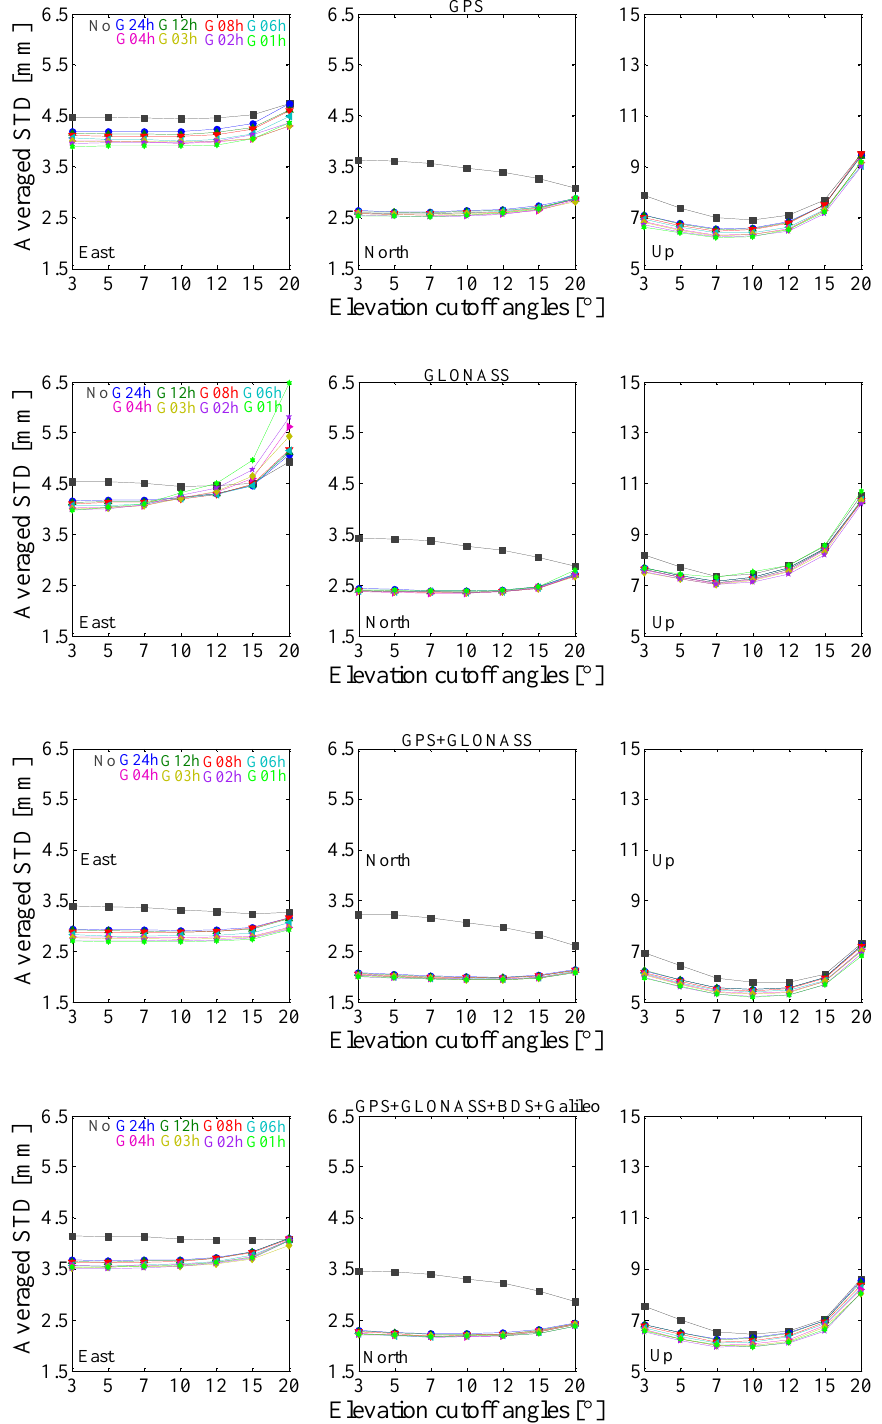
Figure 6. The averaged position repeatability as a function of satellite elevation cutoff angles of the 61 stations for GPS-, GLONASS-only, GPS + GLONASS and GPS + GLONASS + BDS + Galileo PPP solutions.